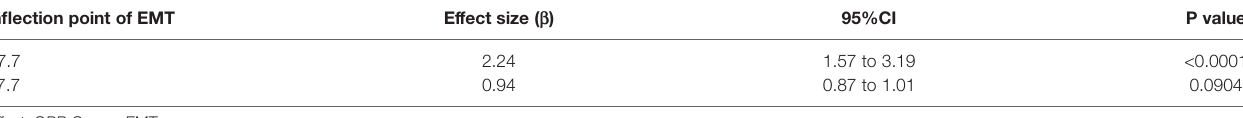
TABLE 2 | Threshold effect analysis of EMT and OPR using linear regression analysis in women < 35 years of age. In fl ection point of EMT